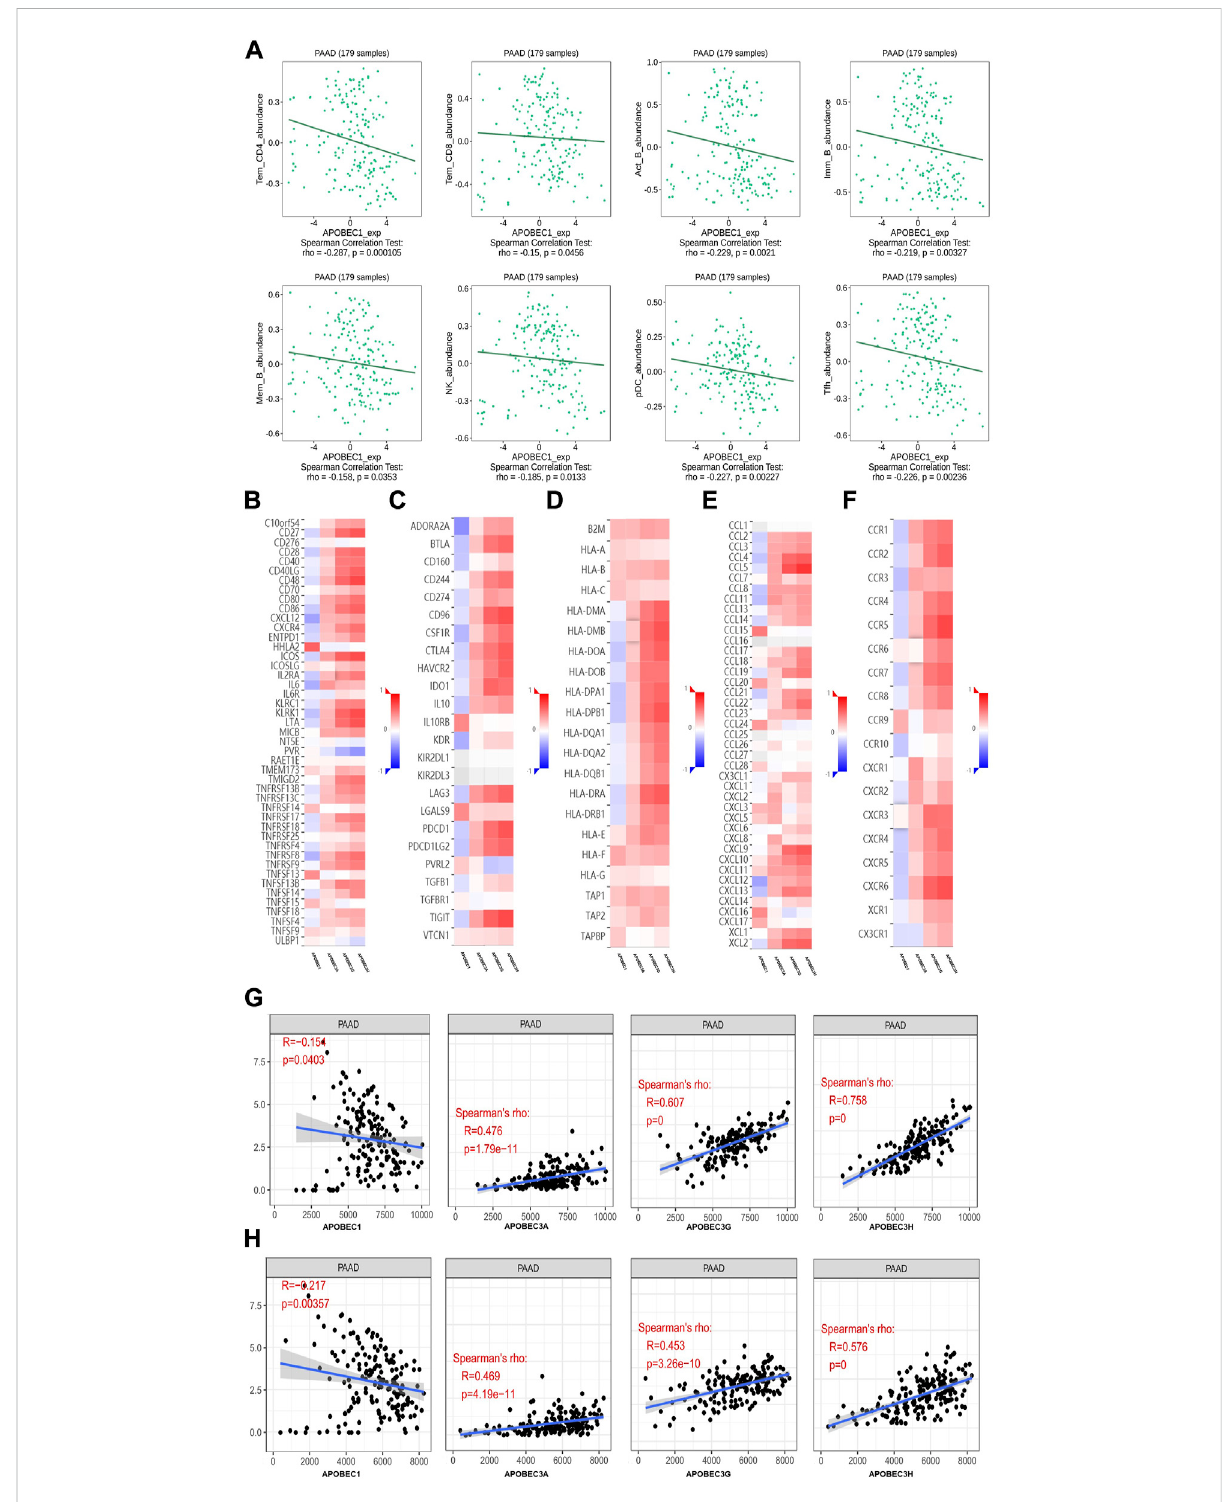
FIGURE 4 The immune landscape of the APOBEC family members APOBEC1, APOBEC3A, APOBEC3G and APOBEC3H in PAAD patients. (A) APOBEC1 was negatively correlated with the in fi ltration levels of various immunocompetent tumor in fi ltrating cells including Tem_CD4, Tem_CD8 and NK; (B – F) APOBEC1 was negatively correlated with the expression levels of most immune promoters and APOBEC3A/3G/3H were positively correlated with most immunomodulators (immune promoters, MHC molecules, chemokines, and chemokine receptors). (G) APOBEC1 was negatively correlated with the immune score and APOBEC3A/3G/3H were positively correlated with the immune score; (H) APOBEC1 was negatively correlated with the matrix score and APOBEC3A/3G/3H were positively correlated with the matrix